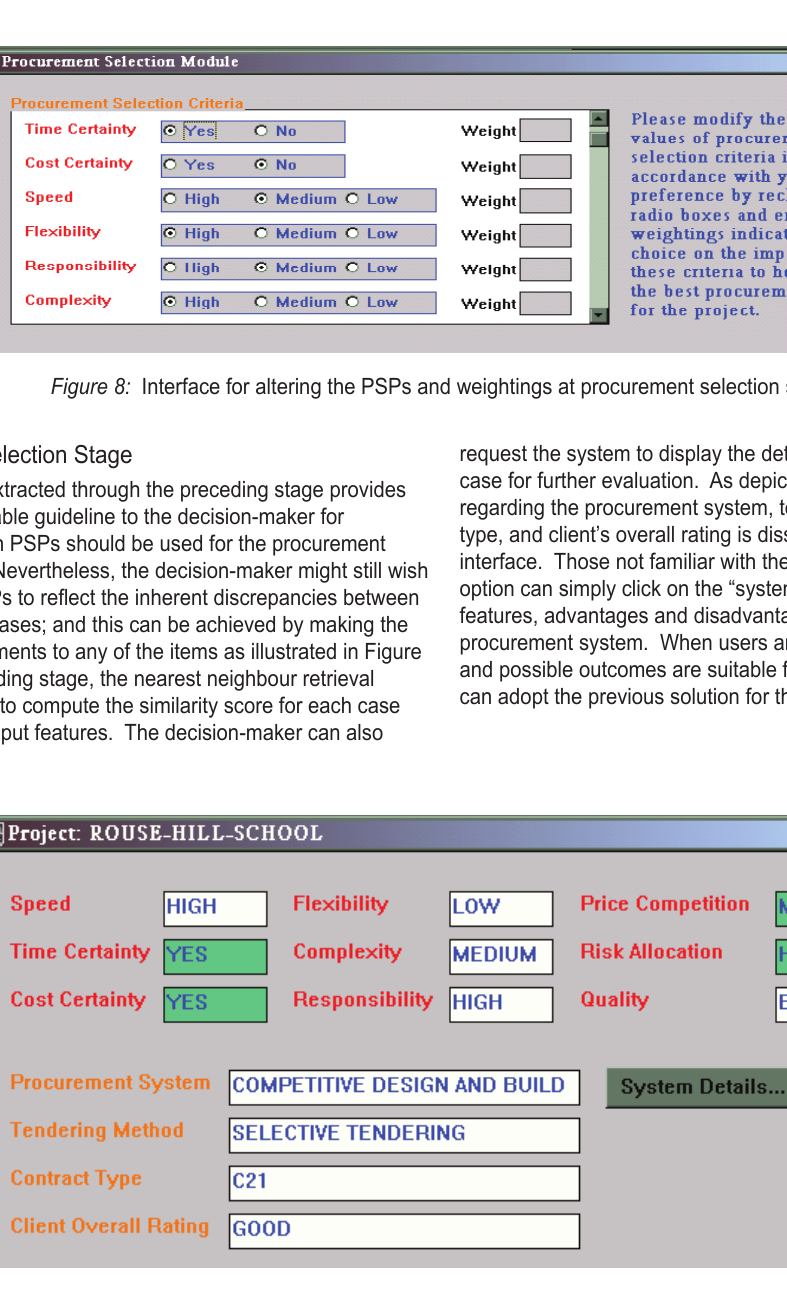
Figure 9: Solution and outcome of the retrieved cases at procurement selection